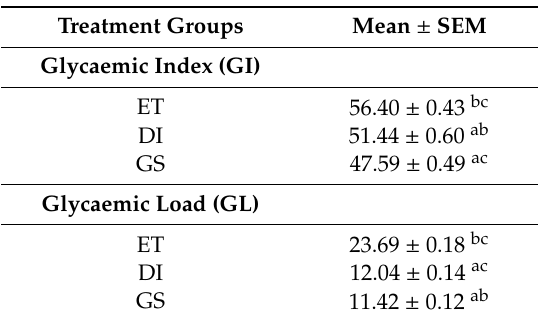
Table 7. Glycaemic index and glycaemic load according to consumption